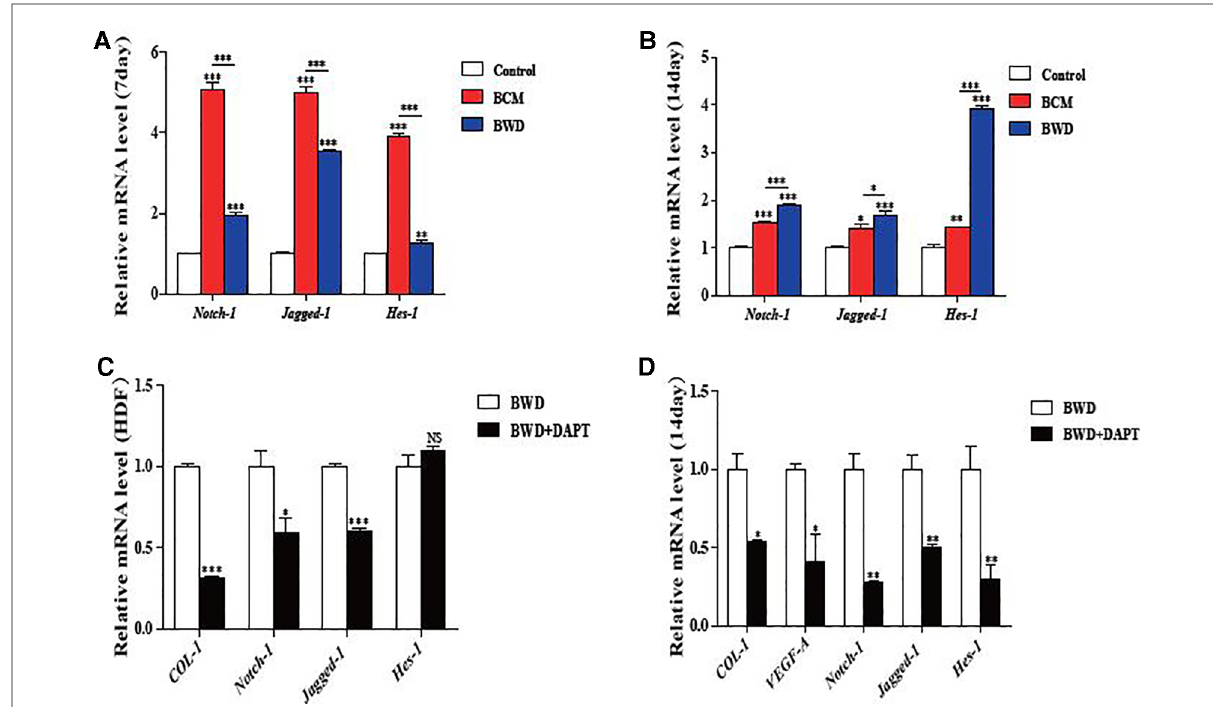
FIGURE 7 Expressions of genes in the notch signaling pathway. ( A ) Expression of genes in the Notch signaling pathway in the wound surface detected by qRT- PCR on day 7. ( B ) Expression of genes in the Notch signaling pathway in the wound surface detected by qRT-PCR on day 14. ( C ) Expressions of the Notch signaling pathway-related genes and COL-1 in HDFs after treatment with the Notch signaling pathway inhibitor DAPT detected by qRT-PCR. ( D ) Expression of Notch signaling pathway-related genes, COL-1 and VEGF-A , in the wound after treatment with the Notch signaling pathway inhibitor DAPT detected by qRT-PCR. Error bars represent SEM ( n =5). NS, no signi fi cant difference, * P ≤ 0.05, ** P <0.01, *** P ≤